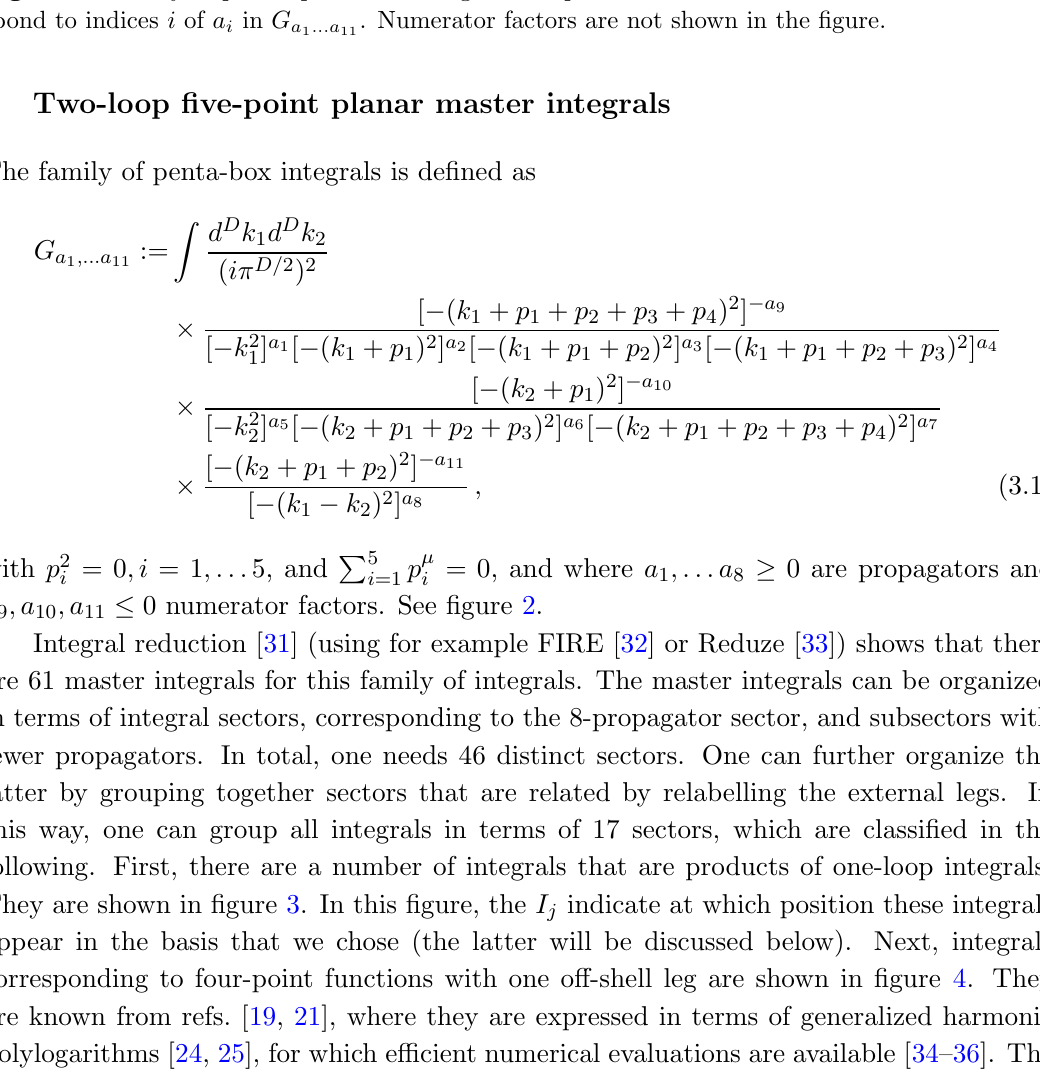
Figure 2 . Family of planar penta-box integrals computed in the main text. The numbers corre- spond to indices i of a i in G a . Numerator factors are not shown in the 1 :::a 11